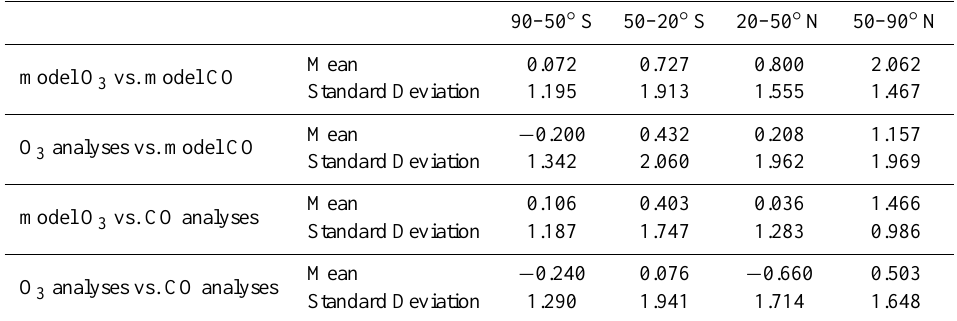
Table 3. Heights of the mean and standard deviation of the ExTL distribution in relative altitude space (km) for the different experiments and for the different latitude bands over the globe, calculated from 15 August 2007 12:00 UTC tracer fields. Negative and positive mean values are below and above the thermal tropopause, respectively.